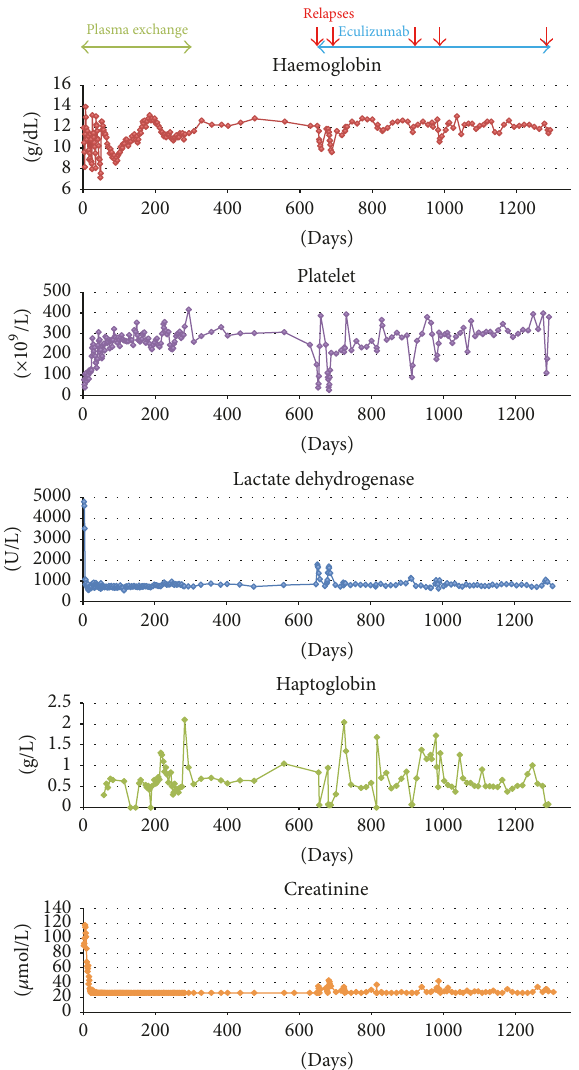
Figure1:GraphicalillustrationofaHUSpatient’sclinicalcourseand treatment. Clinical relapses depicted by red arrows.